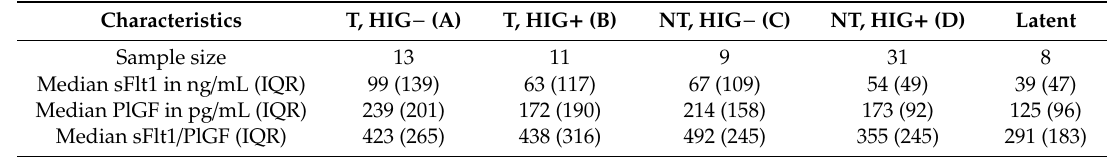
Table 3. Amniotic fluid protein concentrations of sFlt1 and PlGF and the sFlt1 / PlGF ratio.